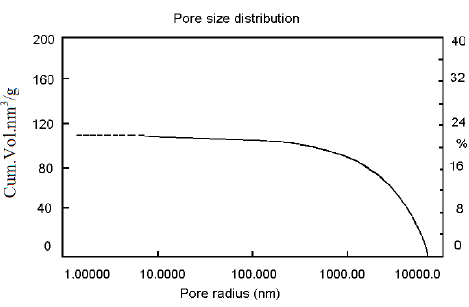
Fig. 4. Pore size distribution of casein biocha r